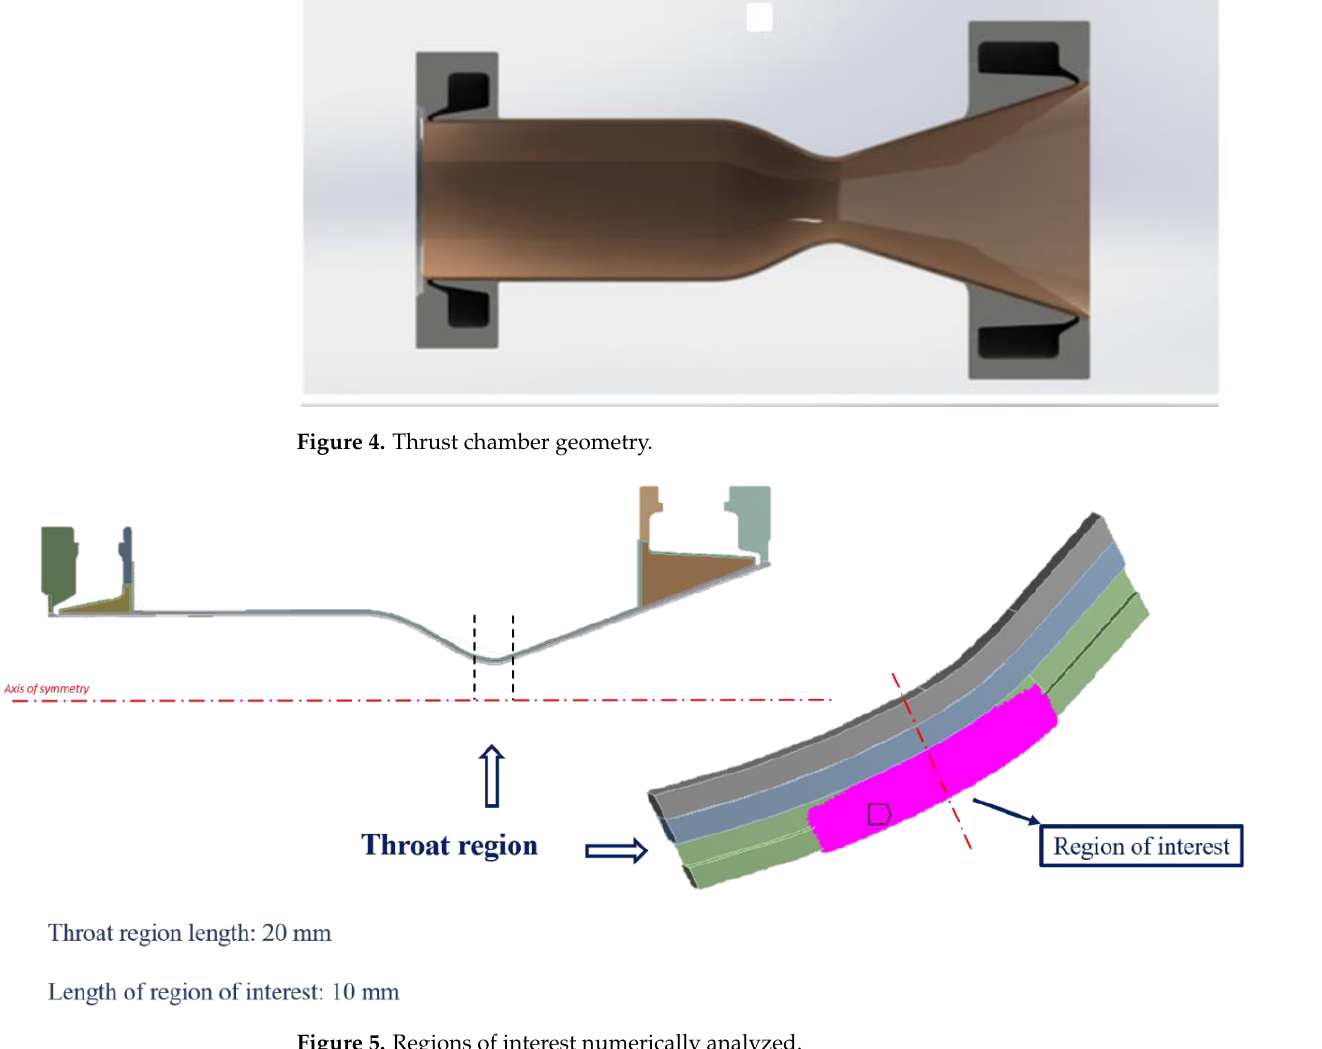
Figure 5. Regions of interest numerically analyzed.